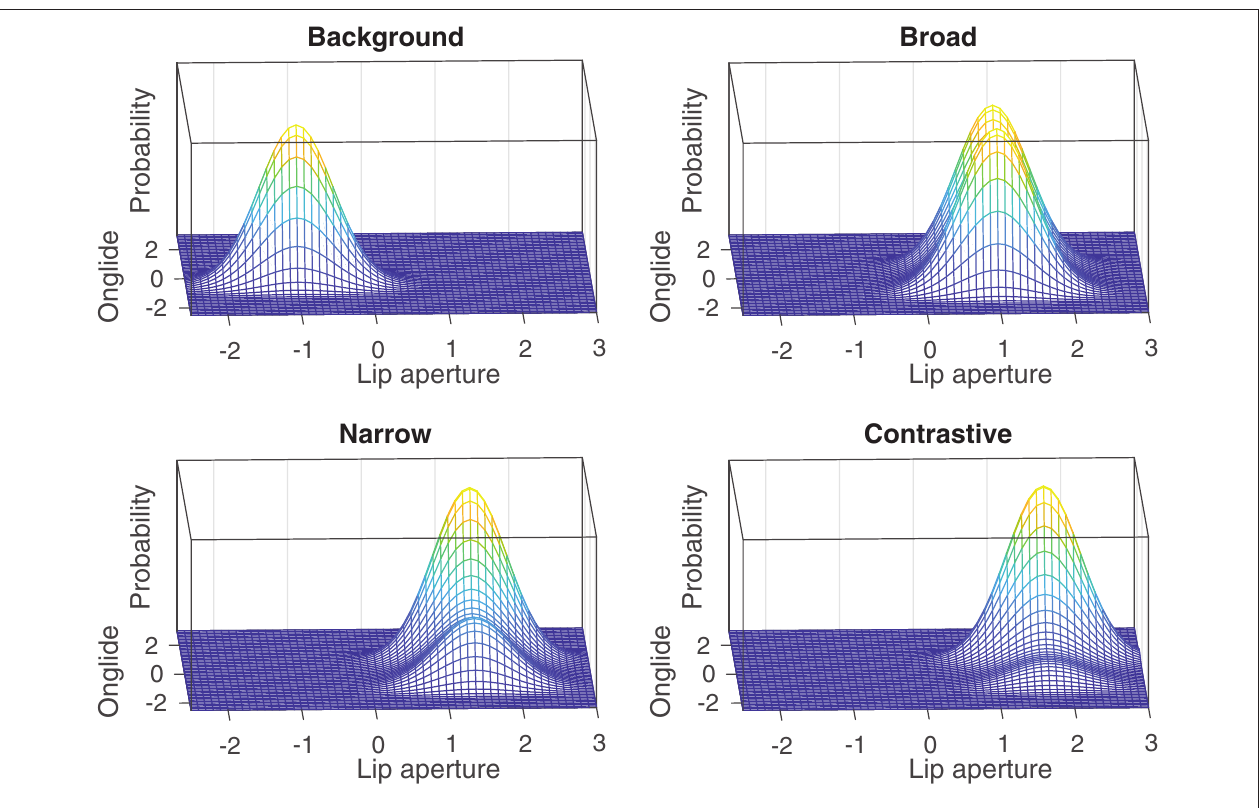
FIGURE 14 | Probability density functions of Figure 13 from a different